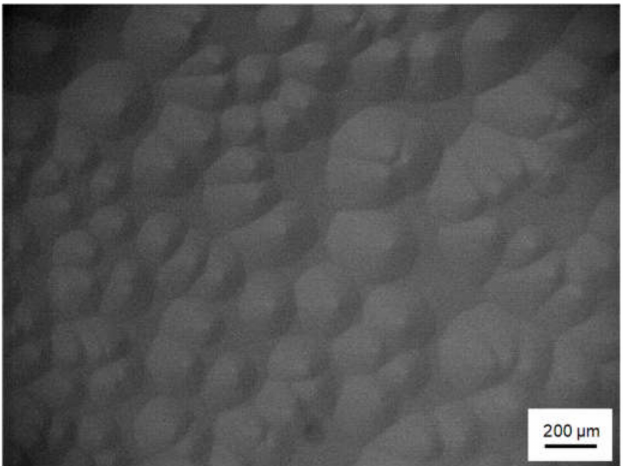
Figure 6. NOM images of the on-axis 4H-SiC epitaxial layer surface at the growth rate and ramp-up time of 40 µ m / h and 60 min,